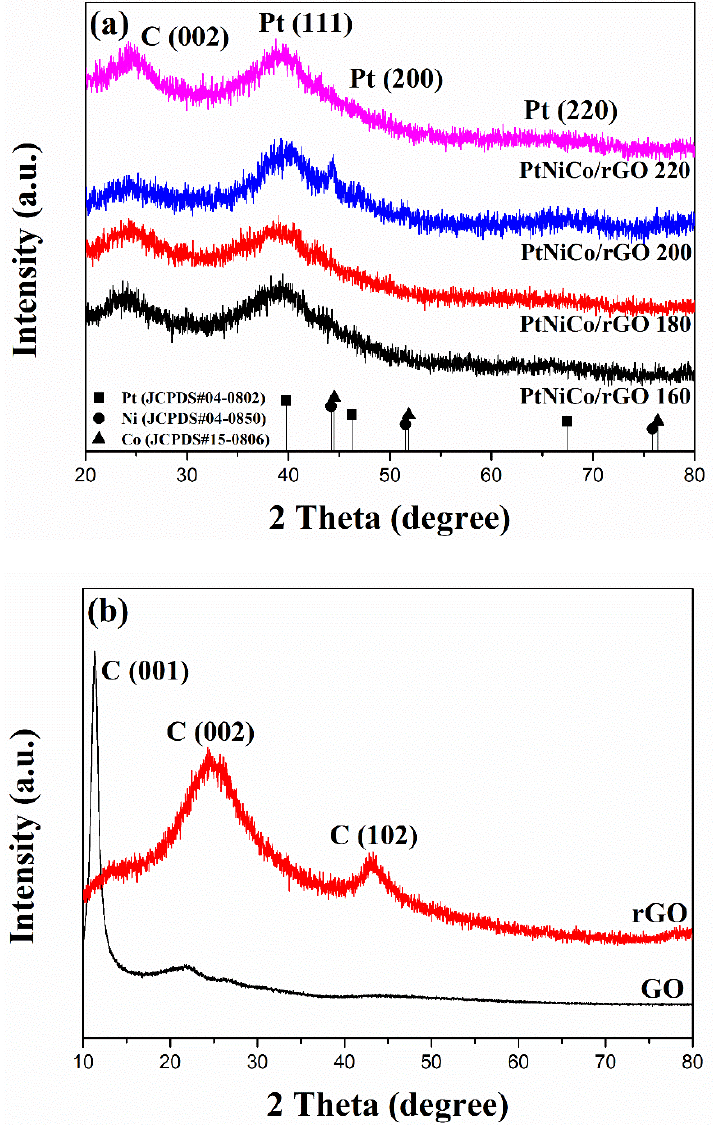
Figure 2. XRD patterns of ( a ) PtNiCo/rGO of different temperatures. ( b ) GO and rGO.